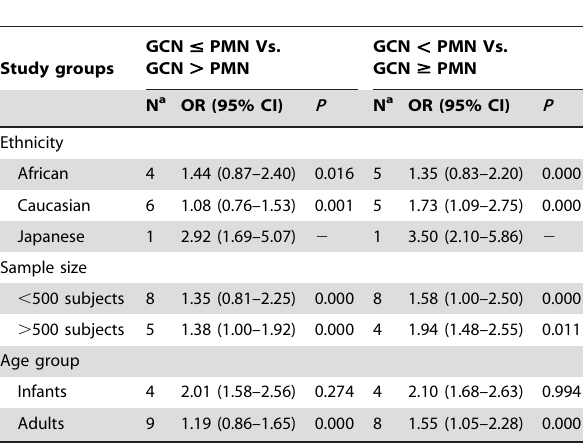
Table 1. Results of meta-analysis for CCL3L1 CNV and HIV-1